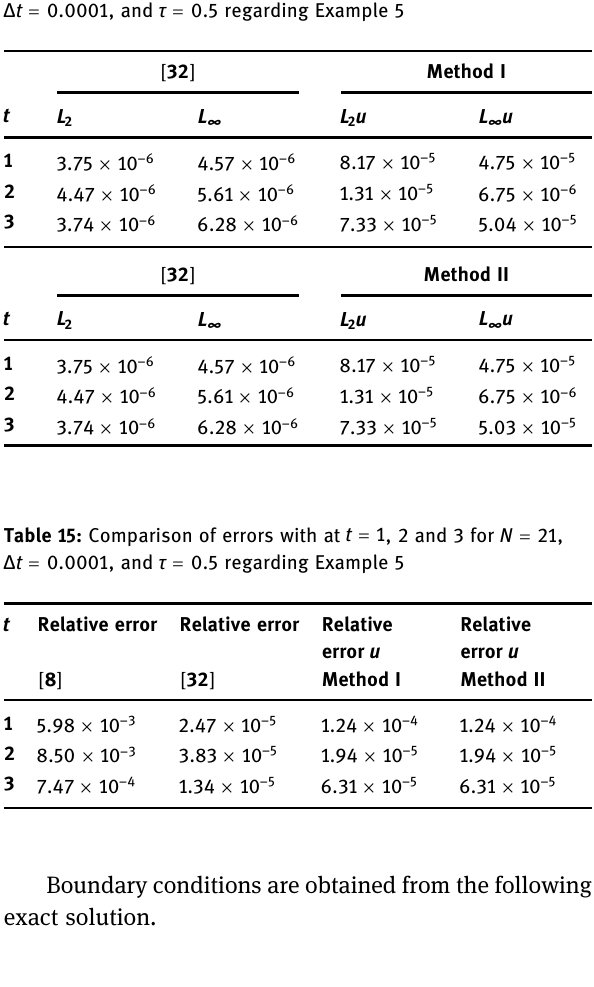
Table 14: Comparison of errors at = t 1 , 2, and 3 for = N 21 , = t Δ 0.0001 , and = τ 0.5 regarding Example 5